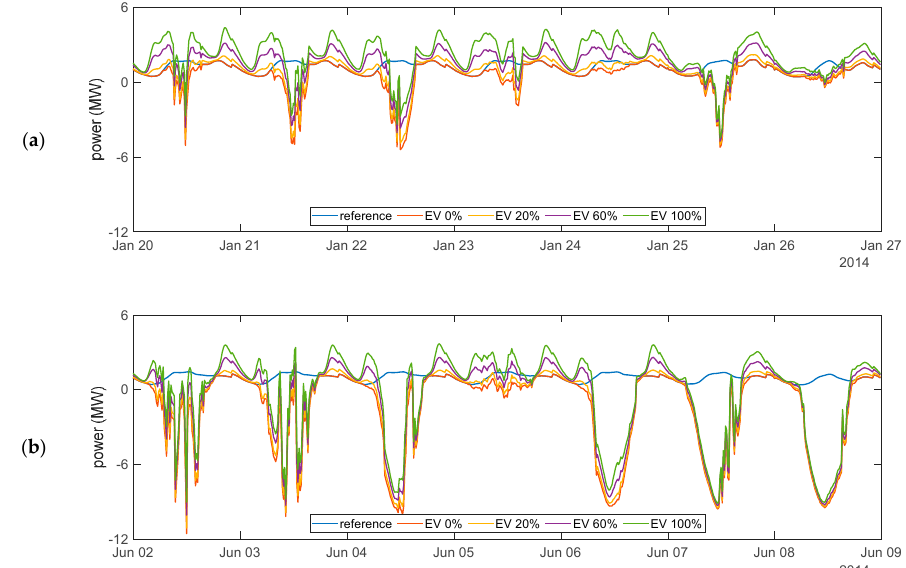
Figure 21. Residual load of cell 13 for the selected worst-case weeks for a fixed penetration of 60% PV and a variation of the penetration of EV for 3.7 kW charging power and charging strategy 1 as well as for the reference scenario (without PV and EV) ( a ) winter ( b ) summer.